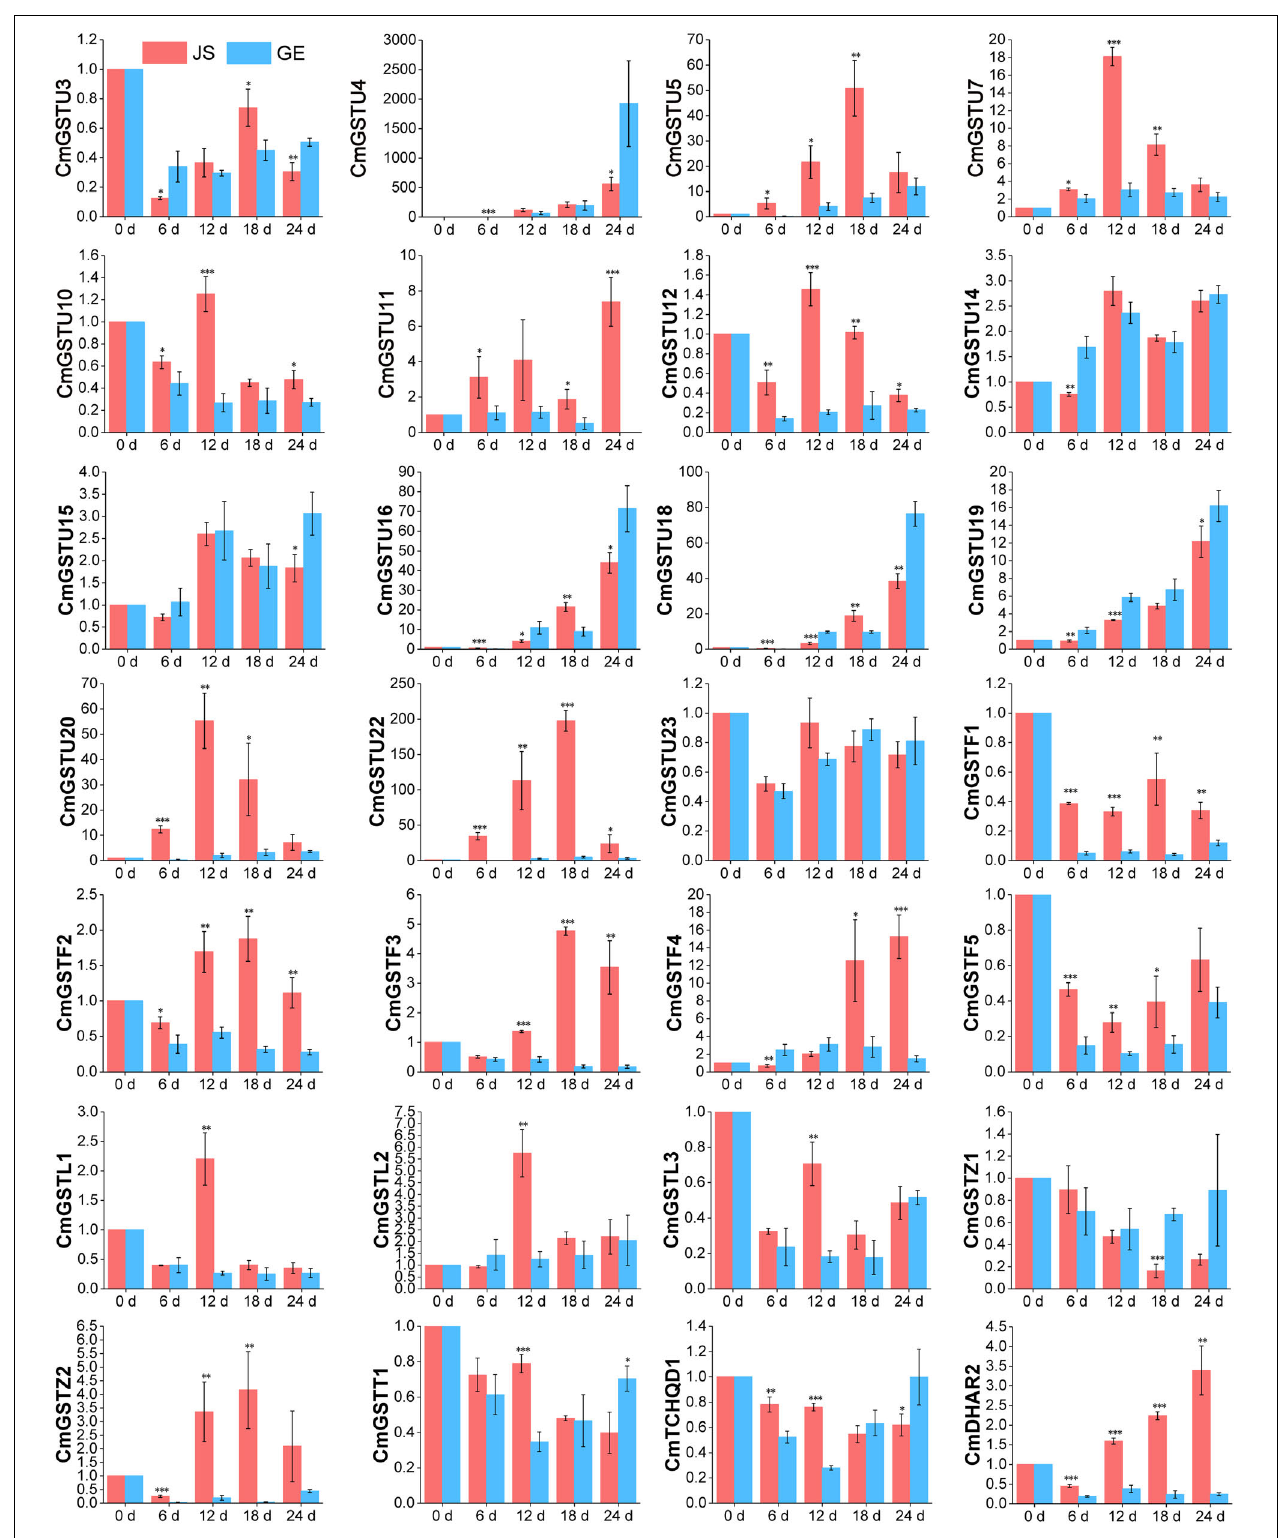
FIGURE 8 | Expression patterns of 28 stress-related CmGSTs in JS and GE under cold treatment as revealed by q-PCR. Values are means ± standard error of three replicates. The error bars represent standard error of the means. The asterisk indicates significant difference (* P < 0 . 05, ** P < 0 . 01, *** P < 0 . 001) among cold treatment for the same sampling